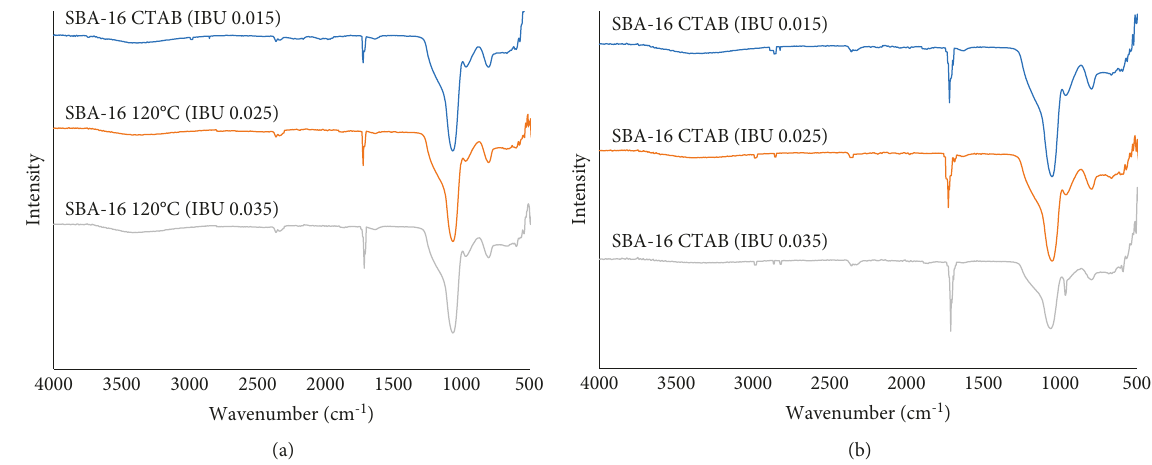
Figure 3: FT-IR spectra of drug-loaded samples. (a) SBA-16 (120 ° C) having IBU conc. at 0.015, 0.025, and 0.035g and (b) SBA-16 modified by CTAB having IBU conc. at 0.015, 0.025, and 0.035g.